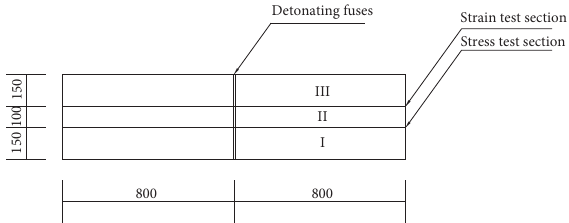
Figure 13: Schematic diagram of layered pouring (unit: